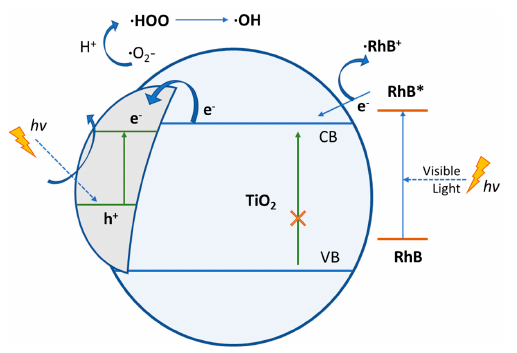
Figure 16. Schematic representation of the photocatalytic degradation of RhB by Ag–TiO 2 NPs, under visible-light irradiation.